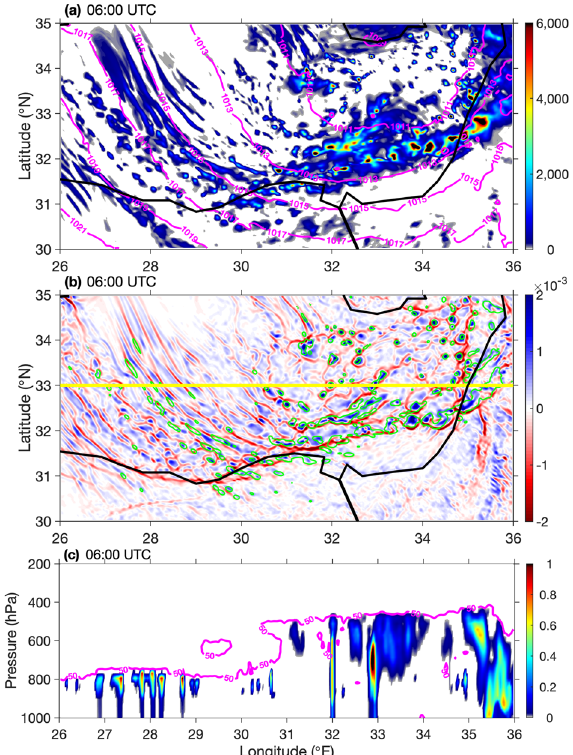
Fig. 3 COSMO simulation results (26 January 2018 at 0600 UTC) over the ROI (marked by the yellow box in Fig. 2a). a Map of total water path (color bar; unit: g m − 2 ) with MSLP (isobars, presented in 2 hPa intervals). b Map of surface wind divergence (color bar; unit: s − 1 ) with surface rain rate ≥ 1 mm h − 1 (green contours). Black thick lines in panel ( a ) and ( b ) mark the coast. c Total water content (color bar;